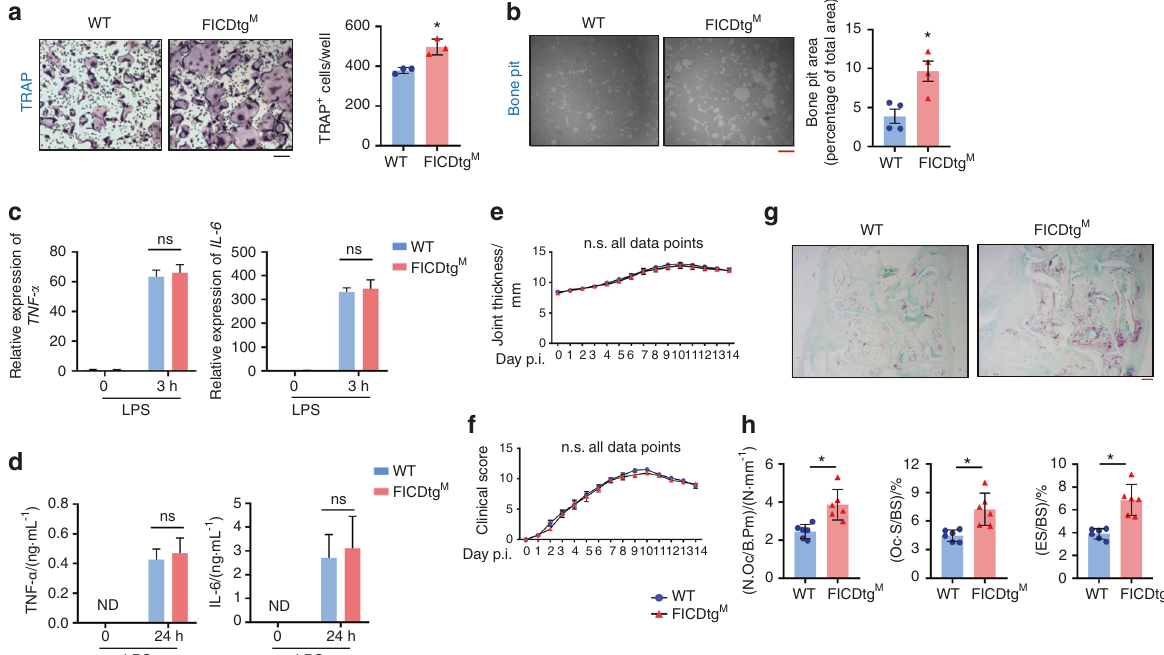
Fig. 5 FICDtg M mice show enhanced arthritic bone erosion. a , b BMDMs from WT and FICDtg M mice were cultured with M-CSF and RANKL for 3 days. a Osteoclastogenesis assay. The left panel shows representative images of TRAP-stained cells. The right panel shows the percentage of TRAP-positive multinuclear cells per WT cell ( n = 3). b Resorption pit assay. The left panel shows representative images, and the right panel shows the percentage of the resorbed pit area per total area ( n = 3). BMDMs from WT and FICDtg M mice were stimulated with LPS (10 ng·mL − 1 ) for 3 h ( c ) and 24 h ( d ). c mRNA expression of TNF- α and IL-6 was measured by q-PCR. d TNF α and IL6 protein levels in the culture media were measured by Luminex multiplex cytokine assays. e – h K/BxN serum transfer-induced arthritis model. Eight-week-old female wild- type and FICDtg M mice were administered K/BxN serum on days 0 and 2. e , f Time course of joint swelling and clinical score analysis of serum- induced arthritis in littermate control and FICDtg M mice ( n = 6). ( g ) Representative images of the TRAP-stained tarsal bones (hind paws) of arthritic mice. h Histomorphometric analysis of tarsal bones. N.Oc/B.Pm Osteoclast number/bone parameter, Oc.S/BS osteoclast surface/bone surface, ES/BS eroded surface/bone surface. The black scale bar is 100 μ m, and the red scale bar is 200 μ m. All data are shown as the mean ± SEM. n.s. not signi fi cant. ND not detected. * P < 0.05 two-way ANOVA with a post hoc Tukey test ( c – f ) or two-tailed, unpaired t -test ( a , b , h FICDtg M cells with CGP57380. As expected, suppressing MNK1/2/ the effect of the FICD on the activation of the mammalian target of the rapamycin (mTOR) pathway and on the induction of the p-eIF4E inhibited the enhanced osteoclastogenesis in FICDtg M MAPK interacting kinase (MNK1/2)-dependent pathway among several key signaling pathways that regulate protein translation 32 . We measured phospho-eIF4E as a downstream readout for the activation of the mTORC1 and MNK1/2 pathways. Strikingly, eIF4E phosphorylation was activated by RANKL stimulation and was signi fi cantly increased in FICDtg M cells compared with WT cells (Fig. 6e), suggesting that the FICD may enhance eIF4E-dependent protein synthesis. To further delineate the cause of the increased eIF4E phosphorylation, we measured phospho-S6K and phospho- 4EBP1 to determine the activation of the mTORC1 pathway. RANKL-induced mTORC1 activation was comparable between FICDtg M and control cells (Supplementary Fig. 10a, b). Consistent with the literature 33 , NFATc1 protein expression was comparable between control cells and RAPTOR-de fi cient cells, which are a model for low mTORC1 signaling (Supplementary Fig. 10c). Our data suggest that the mTORC1 pathway does not regulate FICD- induced eIF4E phosphorylation. We next examined whether the MNK1/2-eIF4E axis regulates RANKL-induced NFATc1 expression using the MNK1/2 inhibitor CGP57380 34 . Inhibiting MNK1/2 activity indeed suppressed RANKL-induced NFATc1 protein expression in a dose-dependent manner in both mouse and human macrophages, whereas Nfatc1 mRNA expression was marginally altered by CGP57380 treatment (Fig. 6f, g, Supplemen- tary Fig. 10d, e). CGP57380 also suppressed osteoclast differentia- tion in a dose-dependent manner in CD14 + cells (Supplementary Fig. 10f). To examine the contribution of the MNK1/2 pathway to the increased osteoclastogenesis in FICDtg M cells, we treated